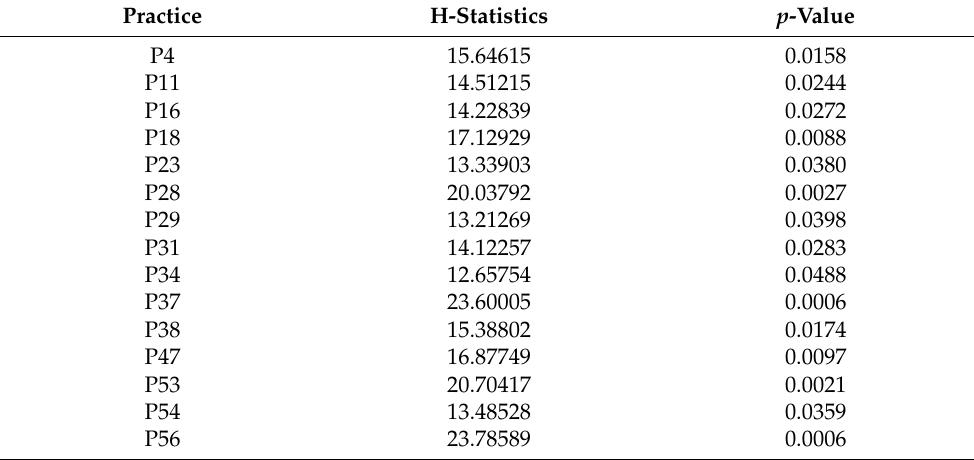
Table 9. The results of calculating the Kruskal–Wallis statistics to test the hypothesis about the